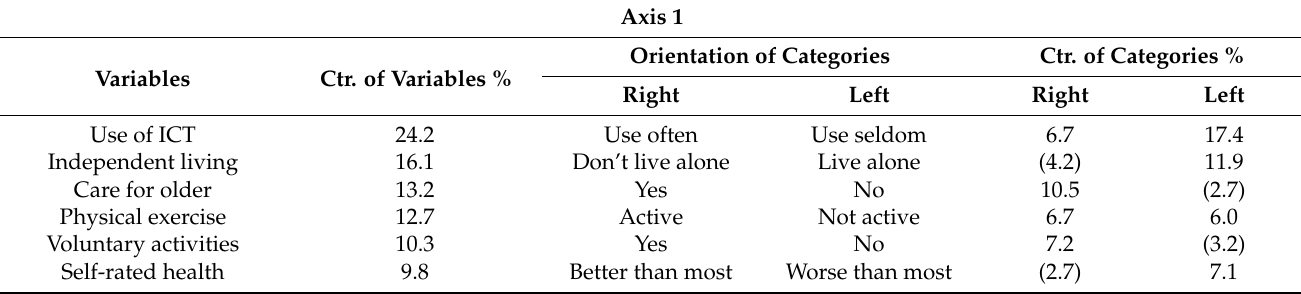
Table 2. Interpretation of Axis 1; 8 response categories contributing above-average to axis variance, 4 additional categories contributing below-average added in brackets. Ctr. of variables and categories are in